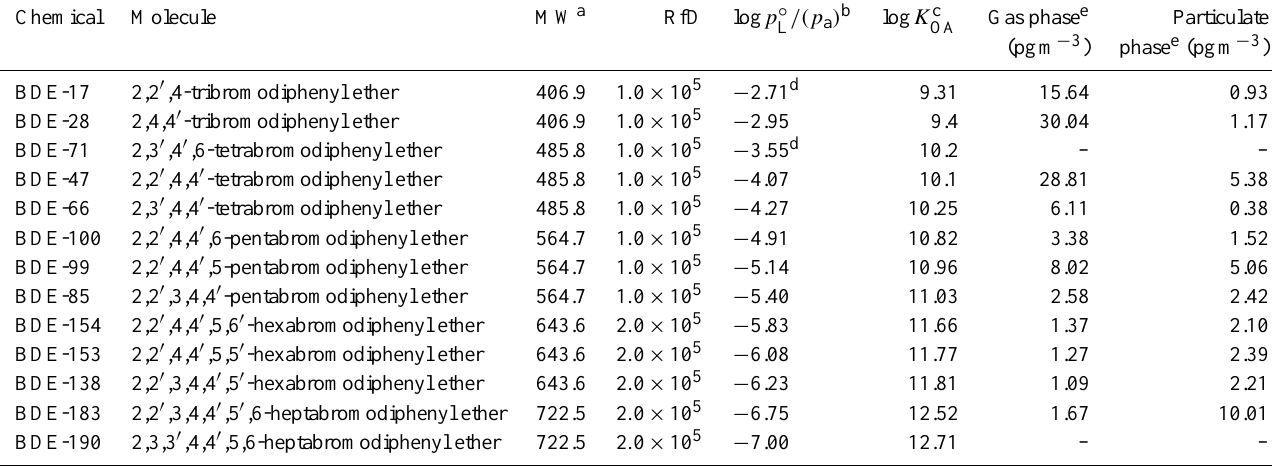
Table 1. Physiochemical properties reference dose (RfD) of the target PBDE congeners and data from Yang et al. (2013). Chemical Molecule MW a